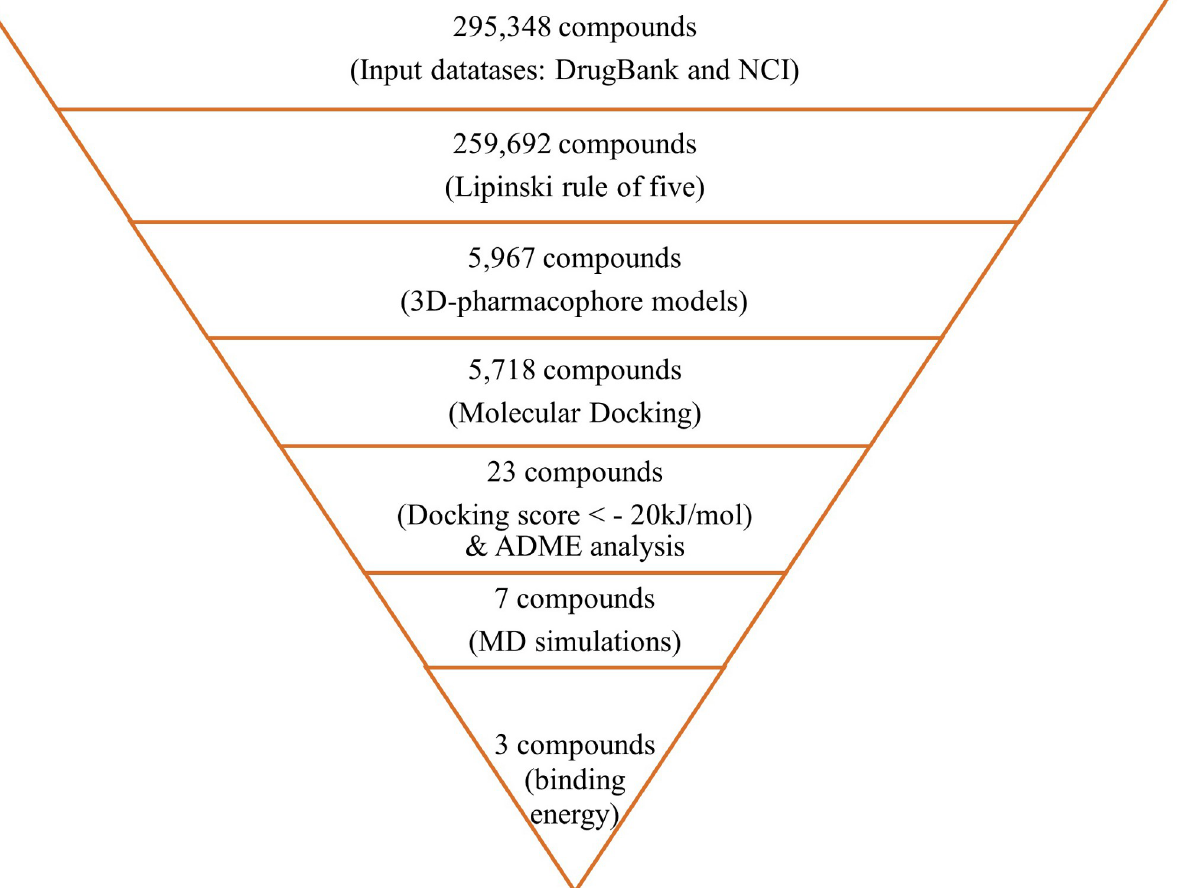
Fig 10. Summarize the studied